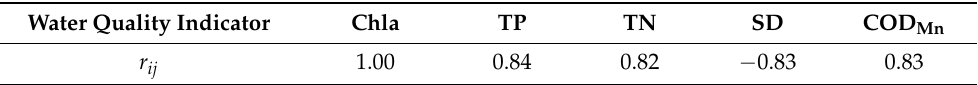
Table 2. Correlation coefficients between Chla and water quality parameters in Chinese lake (reservoirs). Water Quality Indicator